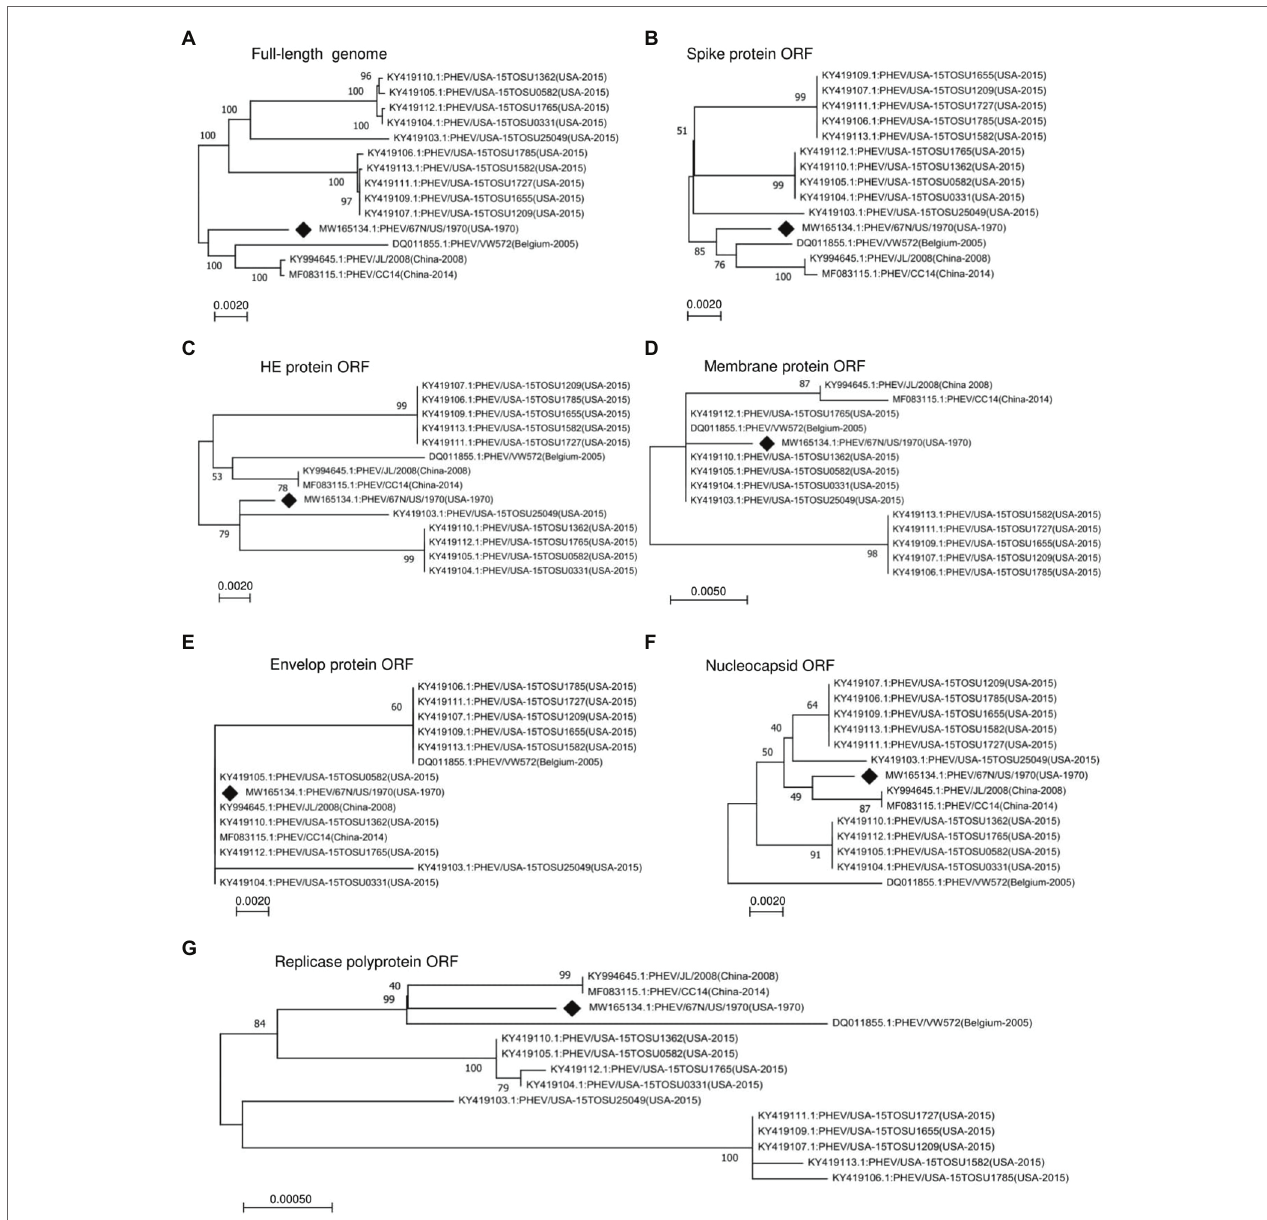
FIGURE 1 | Phylogenetic analysis of 14 PHEV strains isolated between 1970 and 2015. Phylogenetic trees were constructed using the neighbor-joining algorithm in the MEGA-X software and based on (A) Full-length genome, or individual ORFs including (B) spike glycoprotein ORF, (C) HE glycoprotein ORF, (D) membrane protein ORF, (E) envelope protein ORF, (F) nucleocapsid protein ORF, and (G) replicase polyprotein ORF. The numbers on each branch are the bootstrap values (%) in 1000 replicates. The scale bar indicates the amino acid substitution at each position. The strain PHEV/67 N/US/1970 isolated in the United States in 1970 was labeled with a black